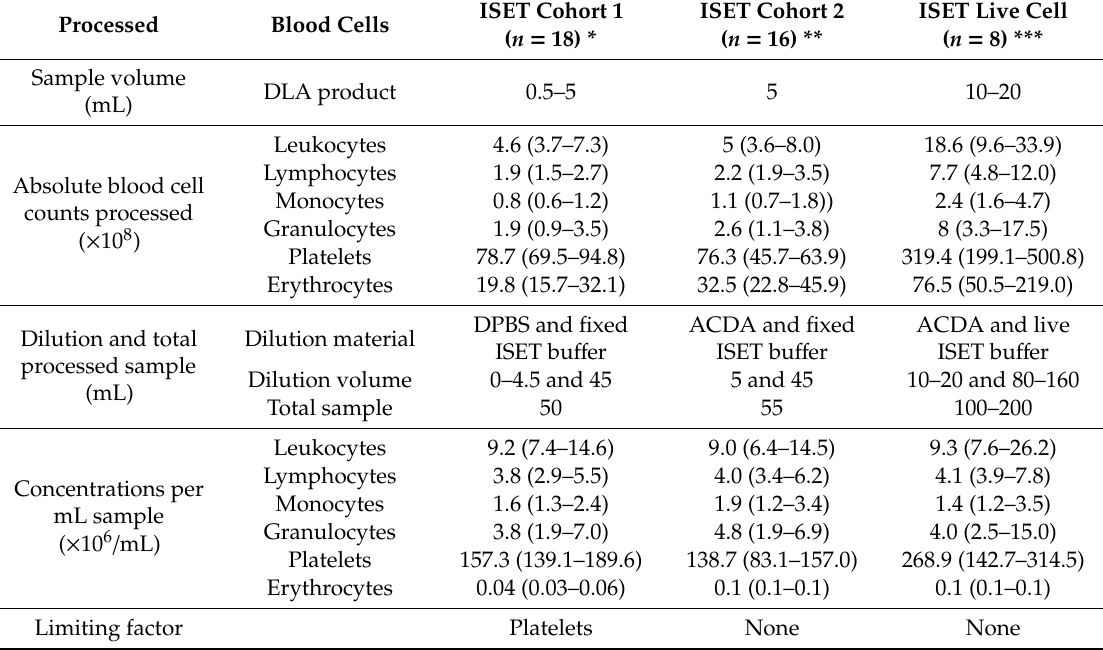
Table A1. Characteristics of filtered diagnostic leukapheresis samples by ISET ® , according to